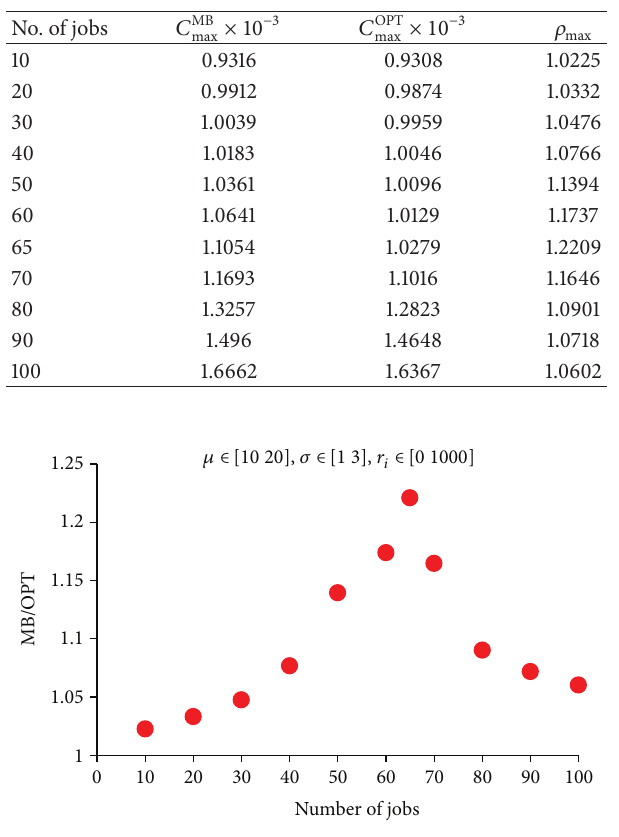
Figure 5: 𝜌 versus the number of jobs.